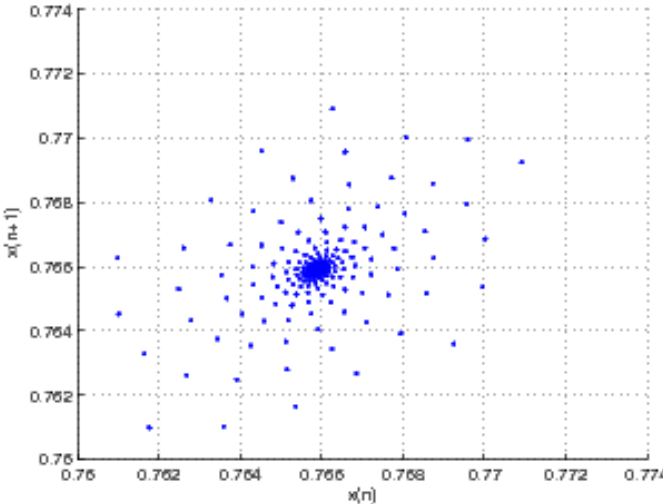
Figure 3. Phase portraits of the map x n + 1 = 0.9 x n + x n − 4 /1.234 + x n − 1 , for B = 0.9.